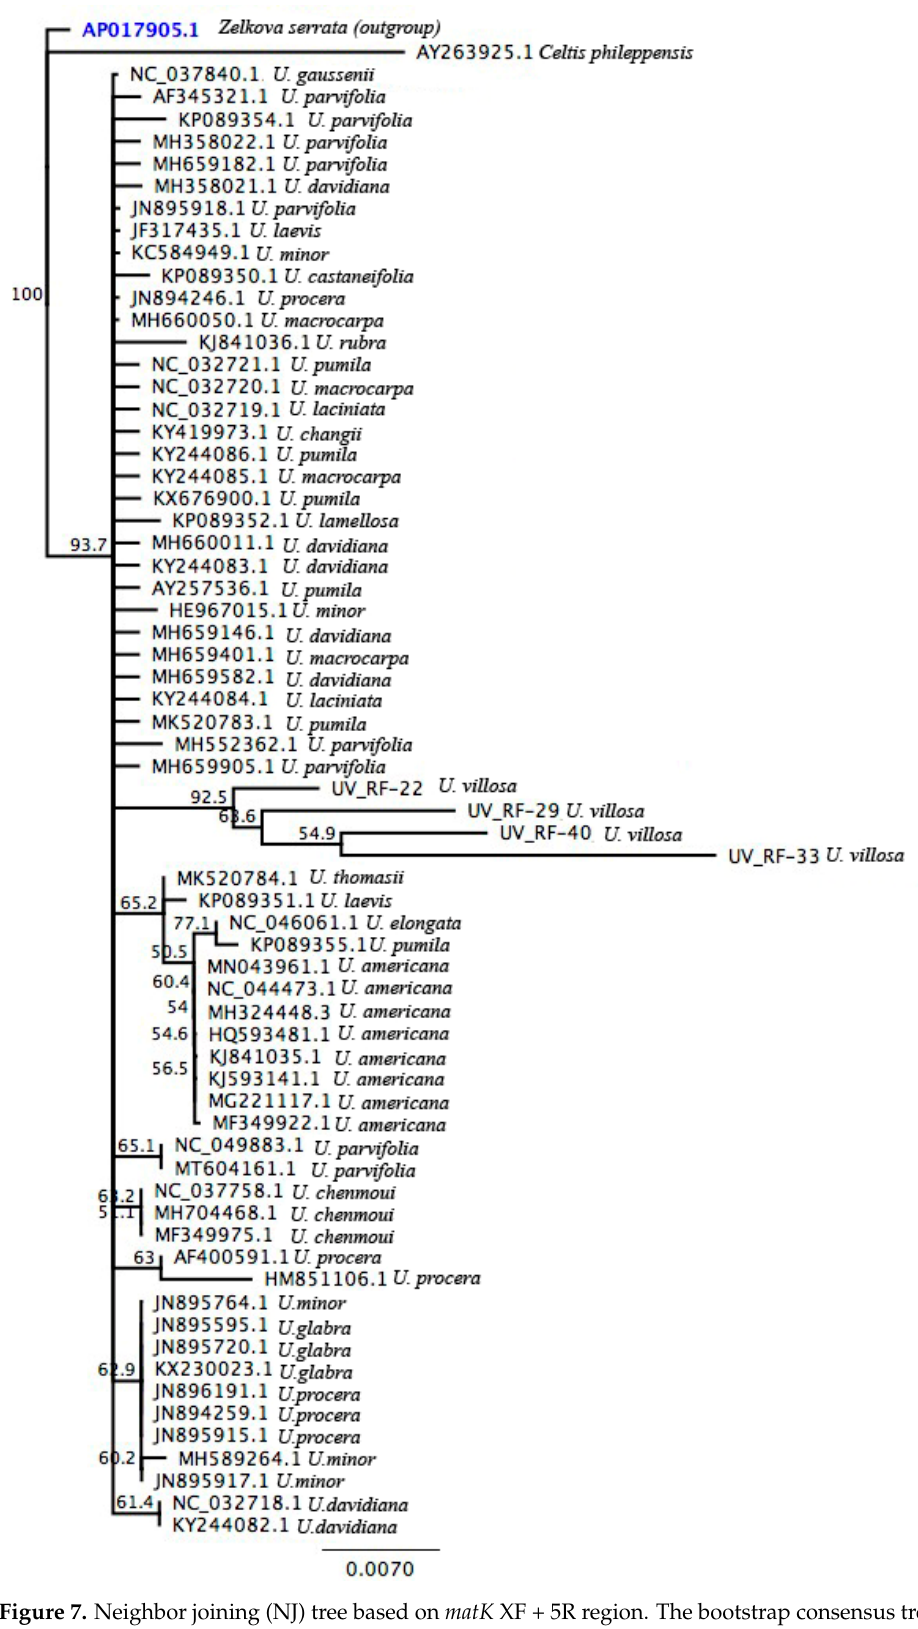
Figure 7. Neighbor joining (NJ) tree based on matK XF + 5R region. The bootstrap consensus tree was inferred from 1000 replicates.